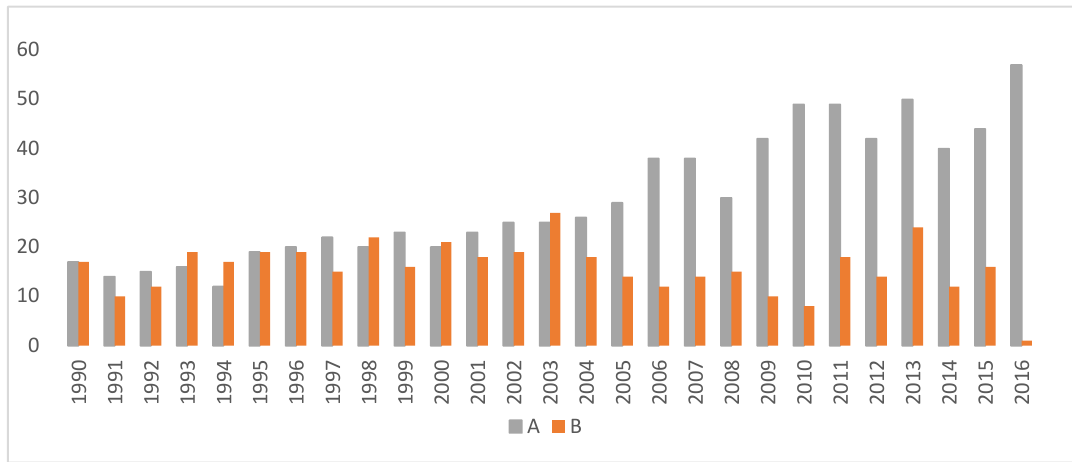
Figure 3. Number of excellent ( A ) and borderline ( B ) canine hip dysplasia (CHD) results in the reference population. A : Excellent; B : Borderline.